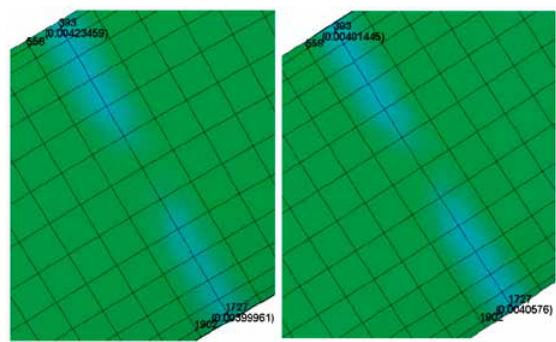
Fig. 15. Error analysis of the element size. Model C is on the left while model D is on the